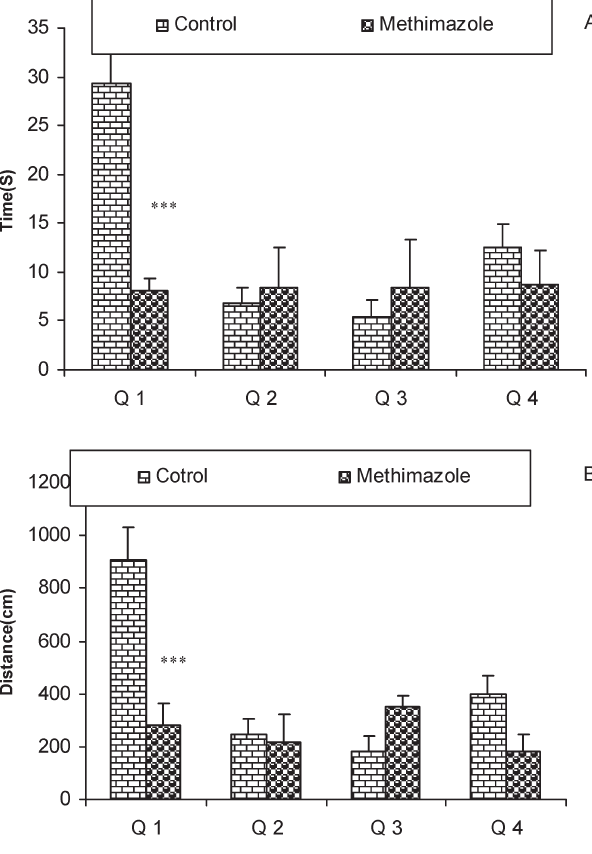
Figure 4 - The results of the time (sec) spent ( 4A ) and the length of the swimming path (cm) ( 4B ) in each quadrant during the probe trial on day 9 (24 h after the last secession of learning). Data are shown as mean ¡ SEM of seven animals per group. The platform was removed, and the time spent and the length of the swim path in the target quadrant (Q1) was compared between the groups. The time spent and the length of the swim path in Q1 by the offspring of the methimazole group was significantly lower compared to controls. *** P , 0.001 compared to